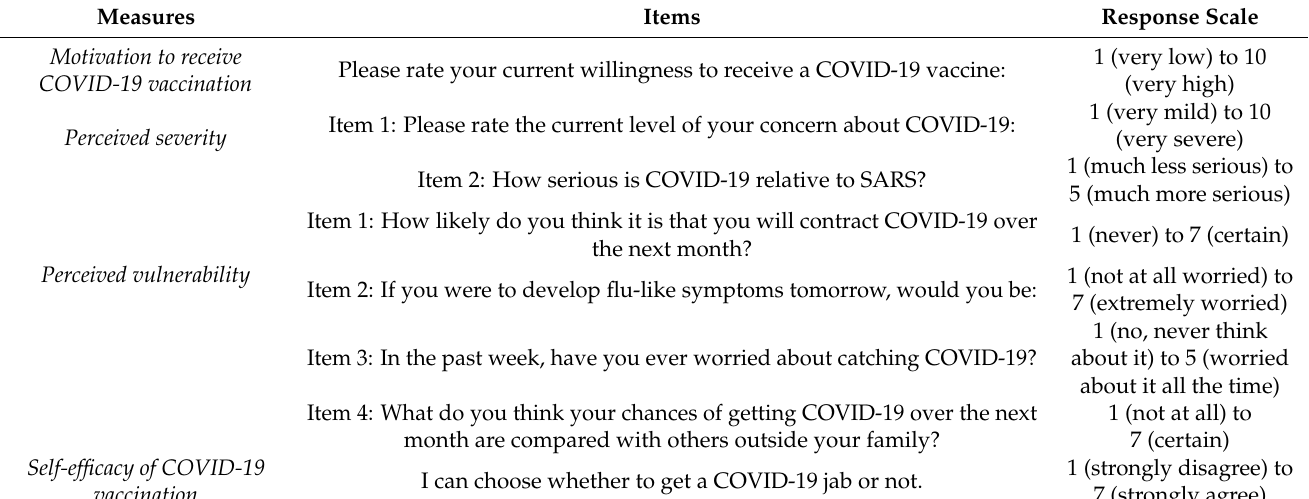
Table 1. Motivation to Receive COVID-19 Vaccination and Constructs of the Extended PMT Related to COVID-19 Vaccination.